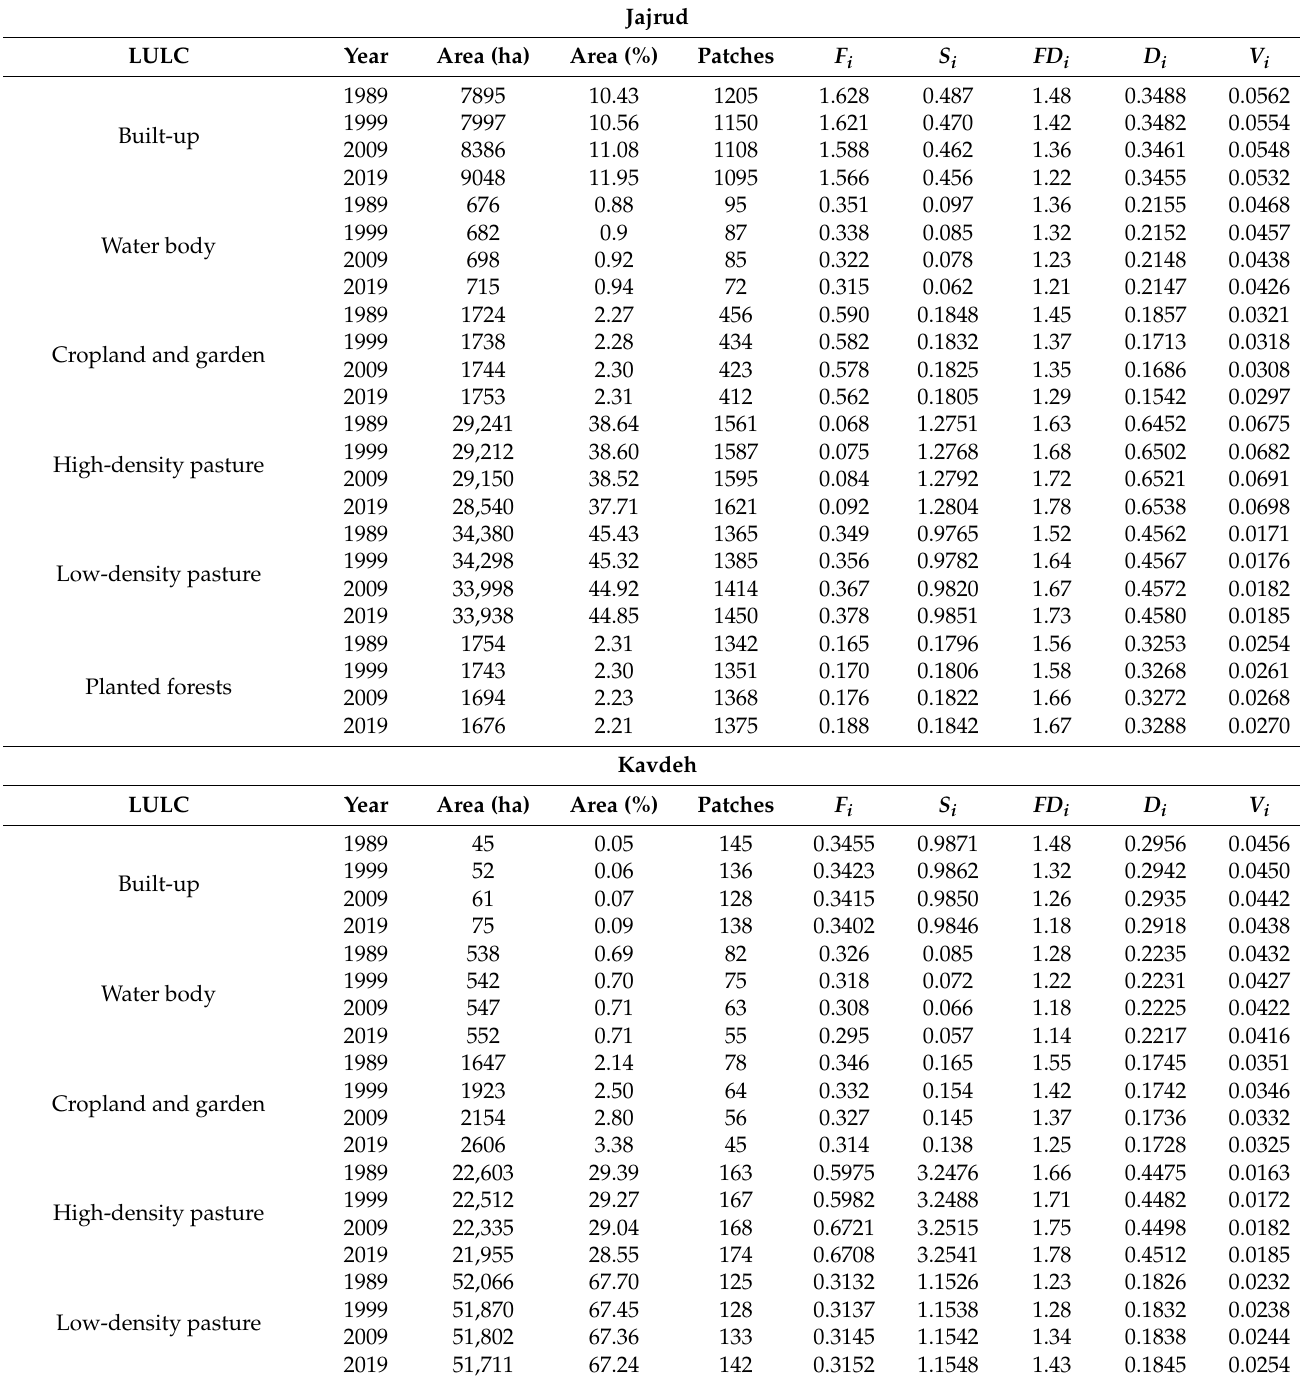
Table 6. Changes of landscape pattern indexes in two Protected Areas in the Tehran province, Iran, over